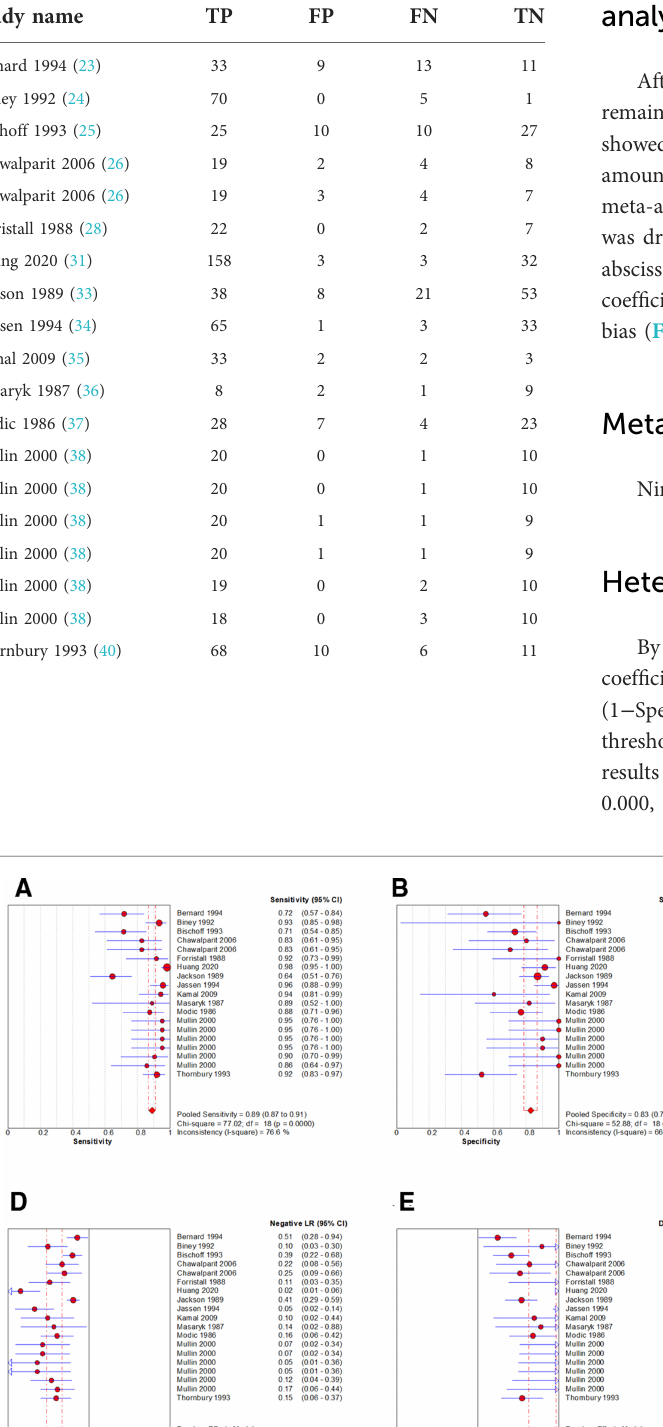
TABLE 2 Characteristics of MRI diagnostic tests.